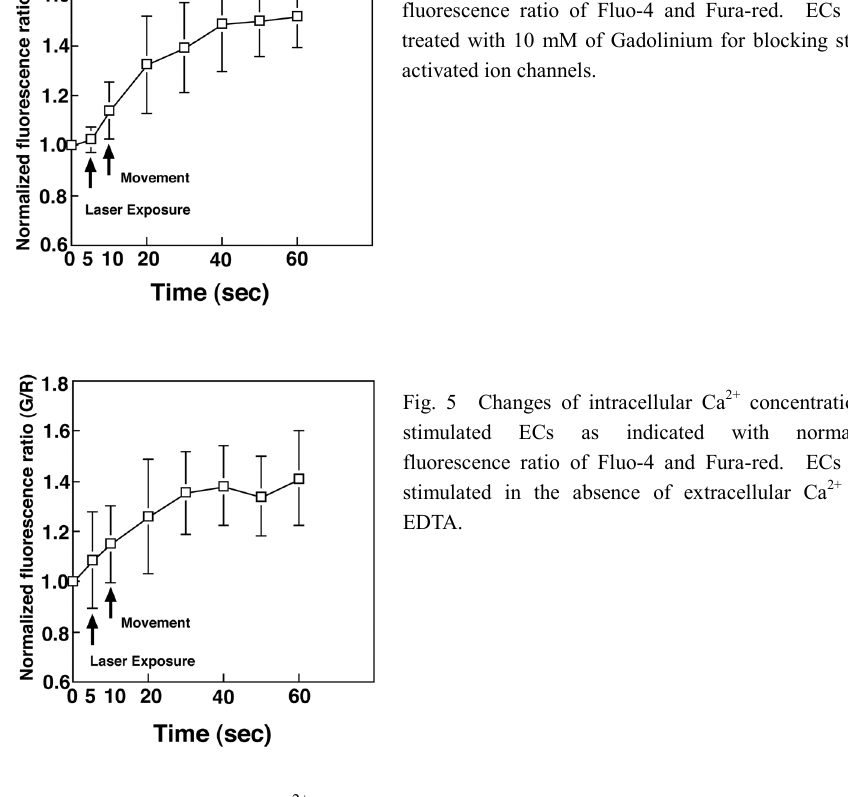
Fig. 4 Changes of intracellular Ca 2+ concentration in stimulated ECs as indicated with normalized fluorescence ratio of Fluo-4 and Fura-red. ECs were treated with 10 mM of Gadolinium for blocking stretch activated ion channels.